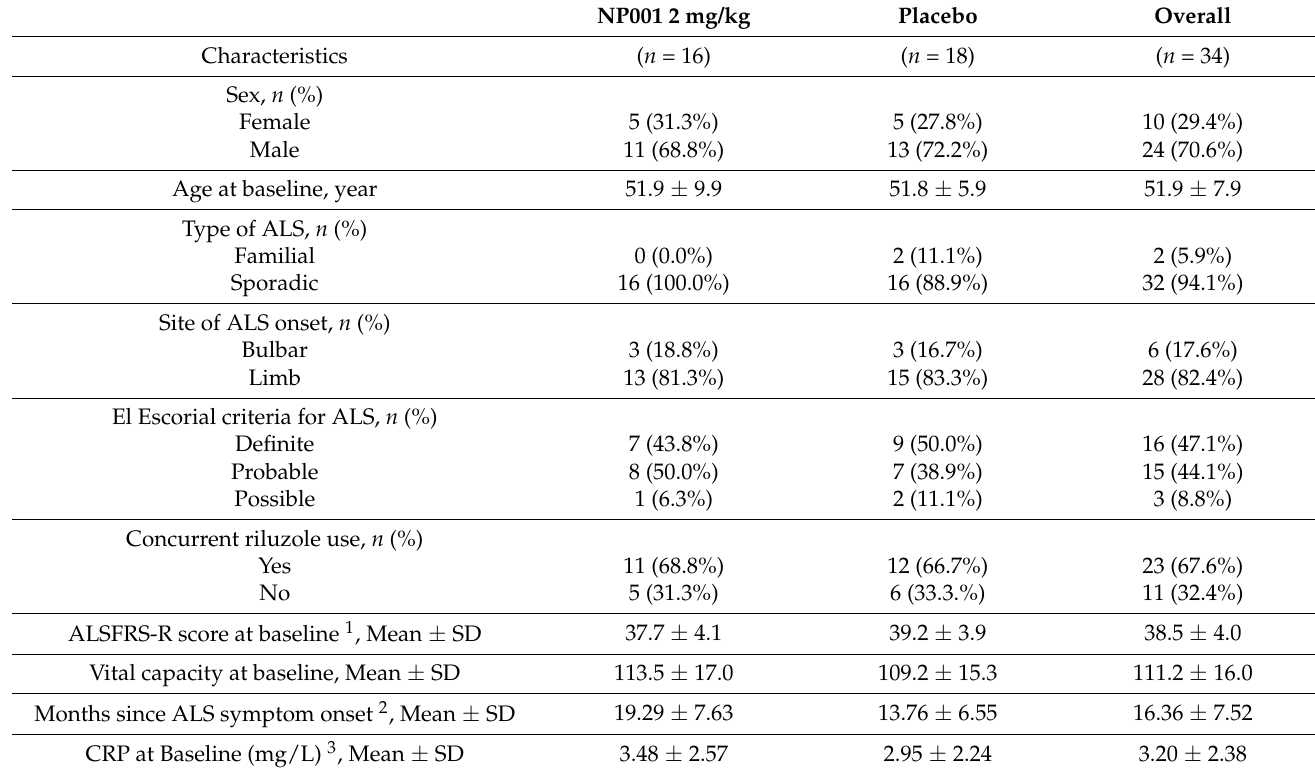
Table 1. Baseline demographics and characteristics of patients ≤ 65 years old and plasma CRP ≥ 1.13 mg/L for those who completed the phase 2A study.